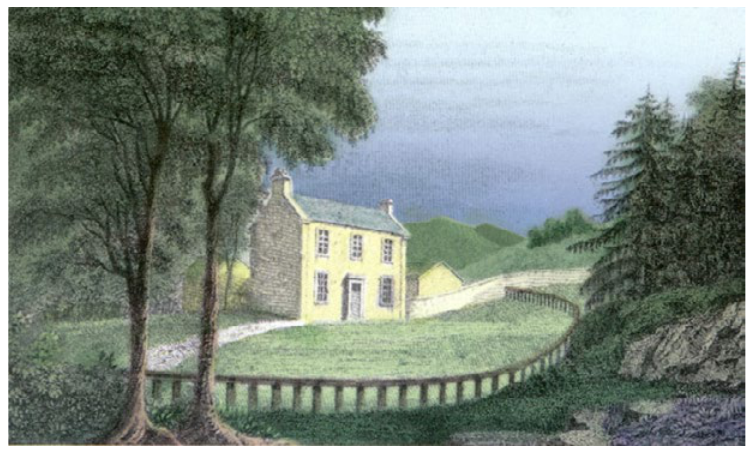
Figure 1.2 Craigenputtock, a property in the family of Jane Carlyle; 1829 watercolour by George